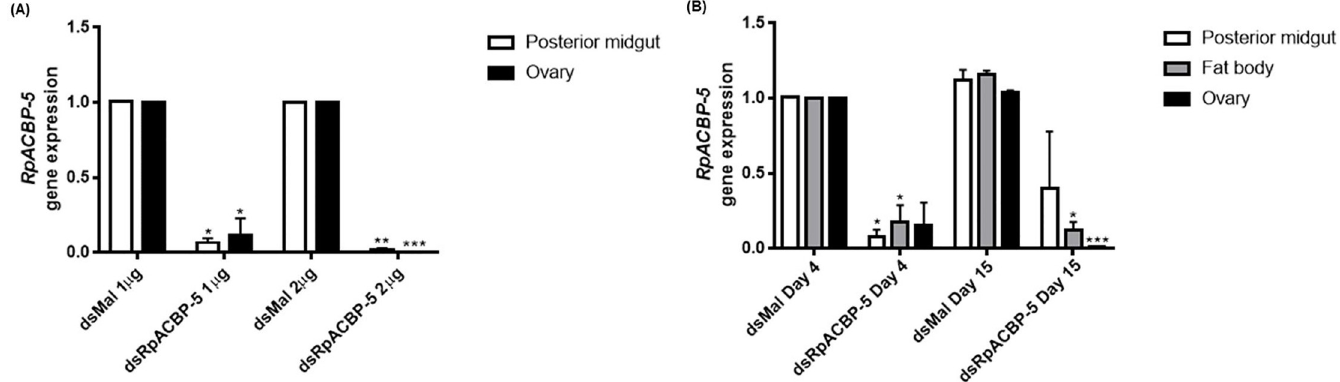
Fig 4. RpACBP-5 knockdown by dsRNA injection. Fasting adult females were injected with 1 or 2 μ g of dsRNA against RpACBP-5 (dsRpACBP-5) or Mal gene (dsMal), and dissected on the third day after injection. Total RNA was extracted from the posterior midgut and ovary (A). Alternatively, fasting females were injected with 1 μ g of dsRpACBP-5 or dsMal, fed three days later, and dissected at the fourth and 15 th day after feeding (B). Total RNA was extracted from the posterior midgut, fat body, and ovary. The RpACBP-5 mRNA levels were quantified by qPCR, using the Rp18S expression as reference gene. The bars are means ± SEM. ( � ), ( �� ) and ( ��� ): significantly different from dsMal by Student’s t -test with p < 0.05, 0.01, and 0.001, respectively. (A) n = 5 or n = 3, for 1 and 2 μ g, respectively. (B) n = 3.